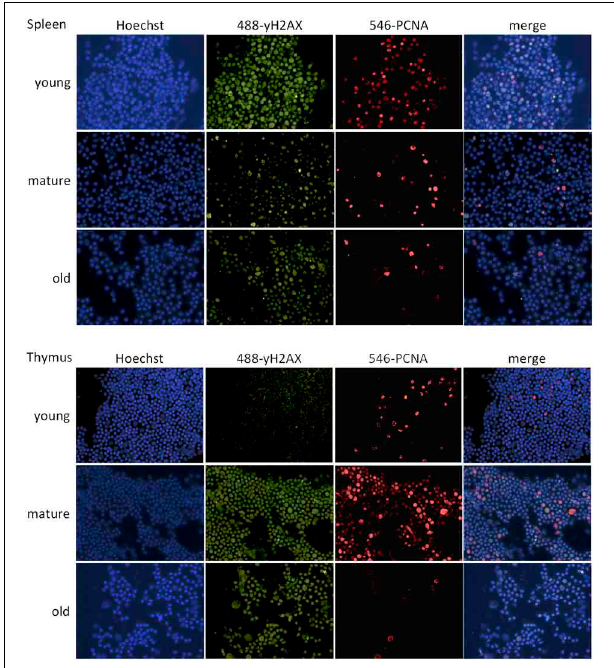
FIGURE 6 | Representative images of γ H2AX-PCNA immunofluorescence staining. Images were taken at 40x